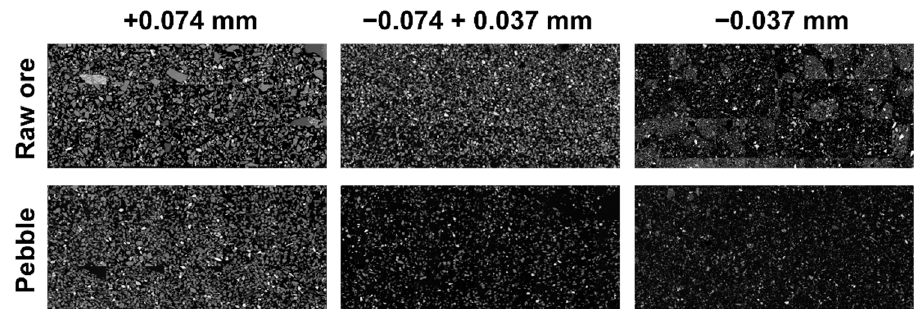
Figure 3. SEM images of representative surfaces. Table 1. The mineral components in the raw ore and pebbles (wt%).